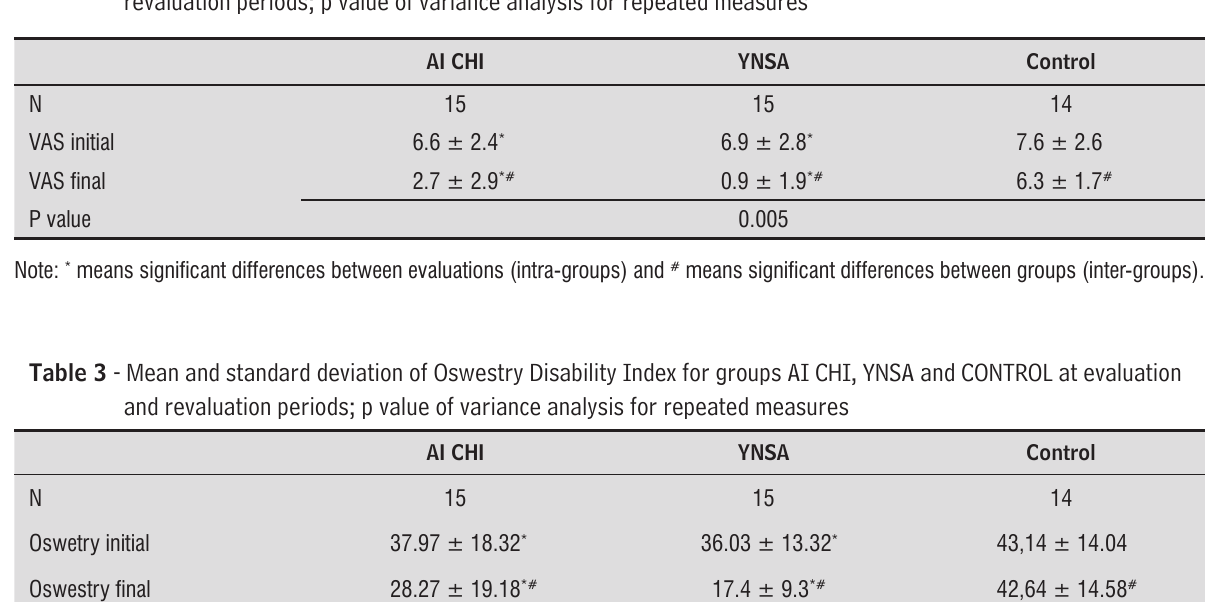
Table 2 - Mean and standard deviation of pain intensity (VAS) for groups AI CHI, YNSA and CONTROL at evaluation and revaluation periods; p value of variance analysis for repeated measures